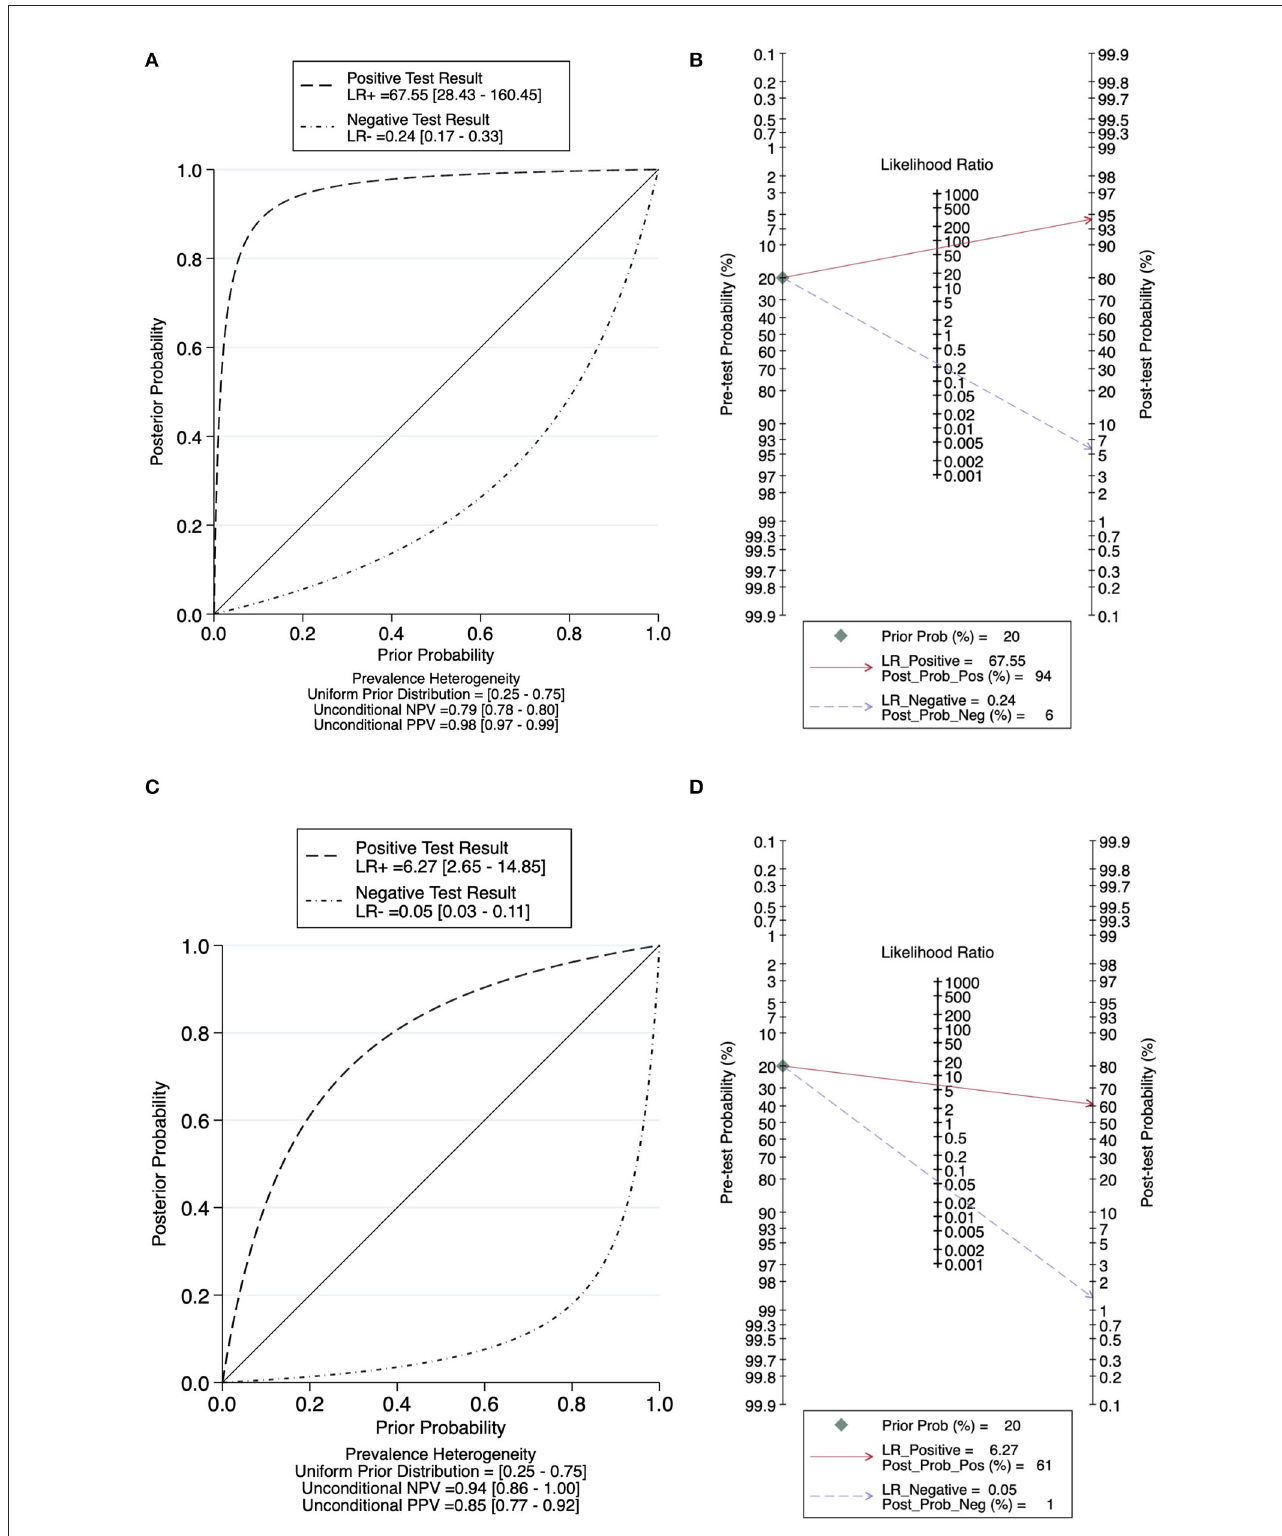
FIGURE5 Probability Modifying Plot and Fagan Plot for evaluating the diagnostic value. (A) Probability Modifying Plot of nontreponemal tests. (B) Fagan Plot of nontreponemal tests. (C) Probability Modifying Plot of treponemal tests. (D) Fagan Plot of treponemal tests.